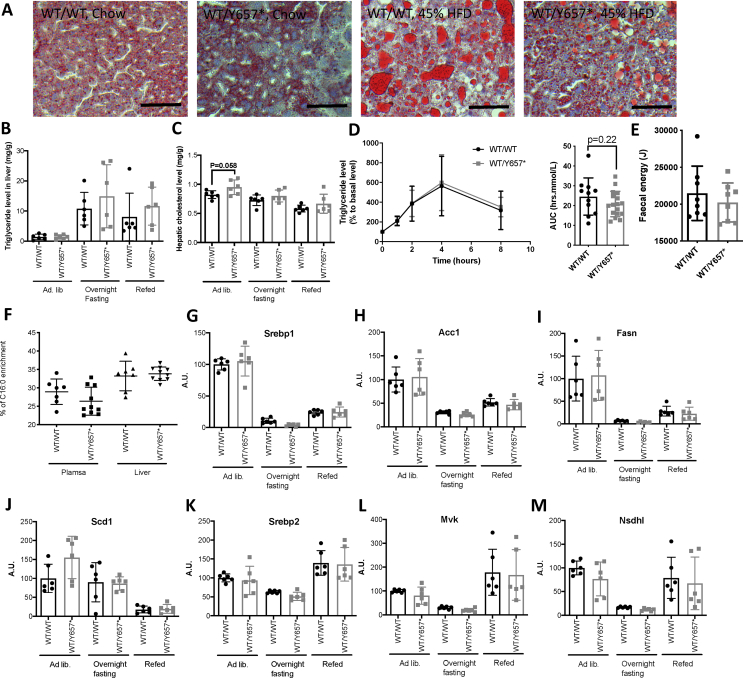
Lipid handling and liver phenotype of Pik3r1WT/Y657∗ mice. (A) Representative images of Oil-Red-O-stained livers of chow-fed and 45% fat diet-fed Pik3r1WT/WT (WT/WT) and Pik3r1WT/Y657∗ (WT/Y657∗) mice. Scale bars = 200 μm. (B) Hepatic triglyceride and (C) Hepatic total cholesterol concentration during a fasting refeeding cycle of chow fed mice at 16 weeks old (n = 6 per genotype). (D) Lipid tolerance testing and comparison of areas under the curve (AUC), also of chow-fed mice, at 16 weeks old. Triglyceride concentrations were equalised at baseline by matching the difference between genotypes with the lower values of heterozygous mice, and the same fixed correction was applied to all points on the graph (n = 11 and n = 17 for wild-type and heterozygous mice respectively). (E) Faecal energy content determined by bomb calorimetry of chow fed mice at 16 weeks old (n = 8 and 8). (F) De novo palmitate measured by stable deuterium enrichment (n = 7 and n = 10 for wild-type and heterozygous mice respectively). (G)–(M) Liver mRNA expression, determined by quantitative real time PCR of (G) Srebp1 and its transcriptional targets (H) Acc1, (I) Fasn, and (J) Scd1, and of (K) Srebp2 and its transcriptional targets (L) Mvk and (M) Nsdhl in chow fed mice during a fasting refeeding cycle at 16 weeks old (n = 6 per genotype per condition). All data shown are from male mice. Numerical data are presented as mean ± SD.